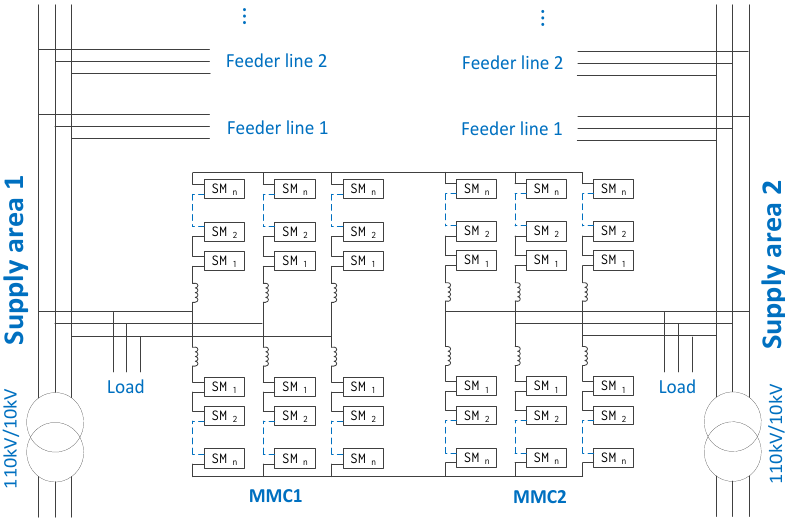
Figure 8. Schematic diagram of simulation model.